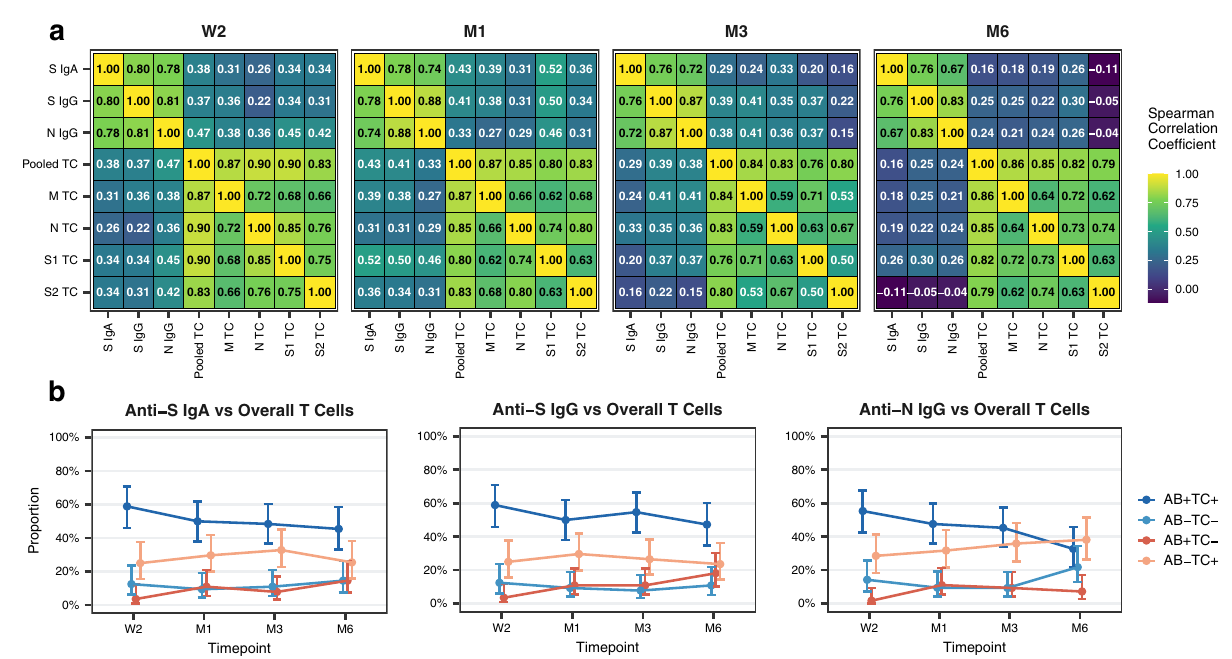
Fig. 5 | Relationship between antibody and T cell responses over time. a Heatmaps demonstrating thecorrelation betweenanti-SIgA, anti-S IgG, and anti- N IgG levels (as mean fl uorescence intensity (MFI) ratios) and M, N, S1, and S2 epitope pool-speci fi c T cells (as spot-forming units (SFU) per 1e6 peripheral blood mononuclear cells (PBMCs))or pooled T cells (summed M, N, S1, and S2 values) at indicated timepoints. Numbers in individual cells correspond to respective Spearman correlation coef fi cients. TC: T cell, W2: two weeks, M1: one month, M3: three months, M6: six months after diagnosis. b Proportion of participants with